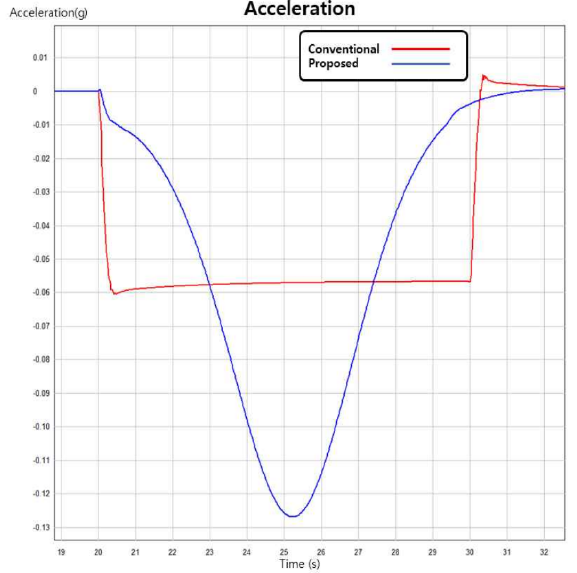
Figure 23. Acceleration comparison when changing speed from 30 to 10 km/h. The maximum deceleration obtained by CRBS was − 0.125 g, and that of the conventional method was − 0.05 g.